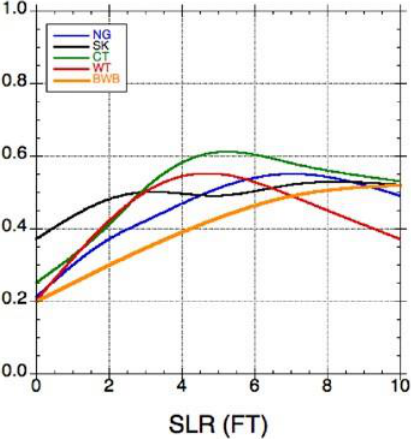
Figure 9. Fraction of houses (%) under 30 ft NAVD88 potentially in harm way (predicted damage larger than 0 %), assuming the most likely scenario for any SLR case between 0 and 10 ft, for Narragansett (NG), South Kingstown (SK), Charlestown (CT), Westerly (WT), and Barrington, Warren, and Bristol (BWB).